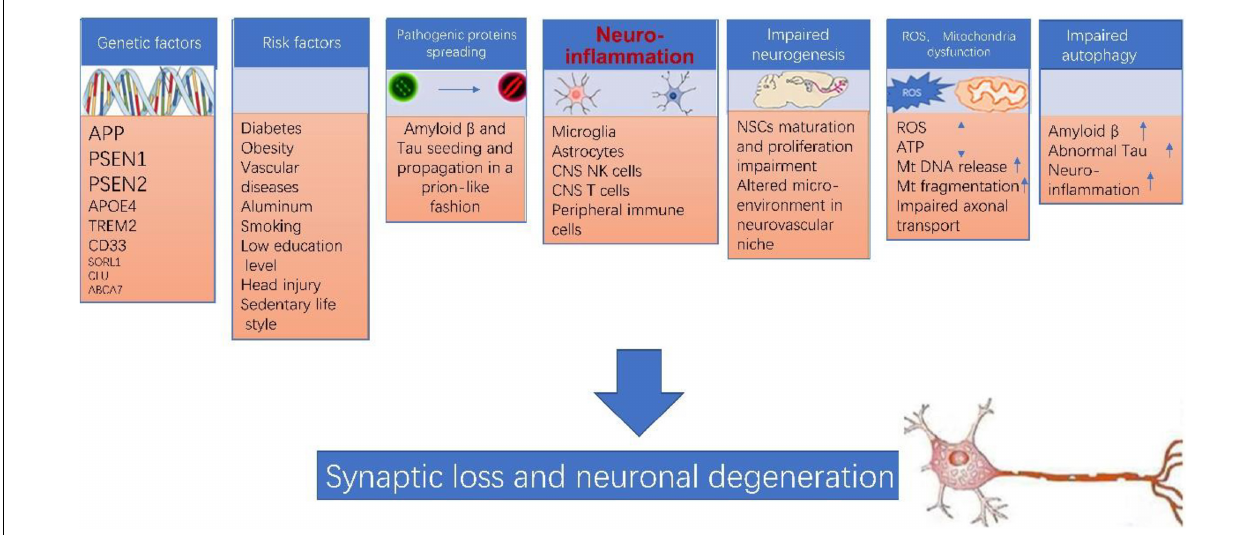
FIGURE 1 | Alzheimer’s disease (AD) pathogenesis. The pathogenesis of AD is extremely complicated, various players such as genetic factor, environment factor, neuroinflammation, pathogenic protein propagation, impaired neurogenesis, mitochondrial dysfunction, ROS accumulation, impaired autophagy likely are all involved in this process, and more importantly, many of these factors interconnect and form a vicious cycle which collectively leads to synaptic loss and neuronal degeneration in AD.